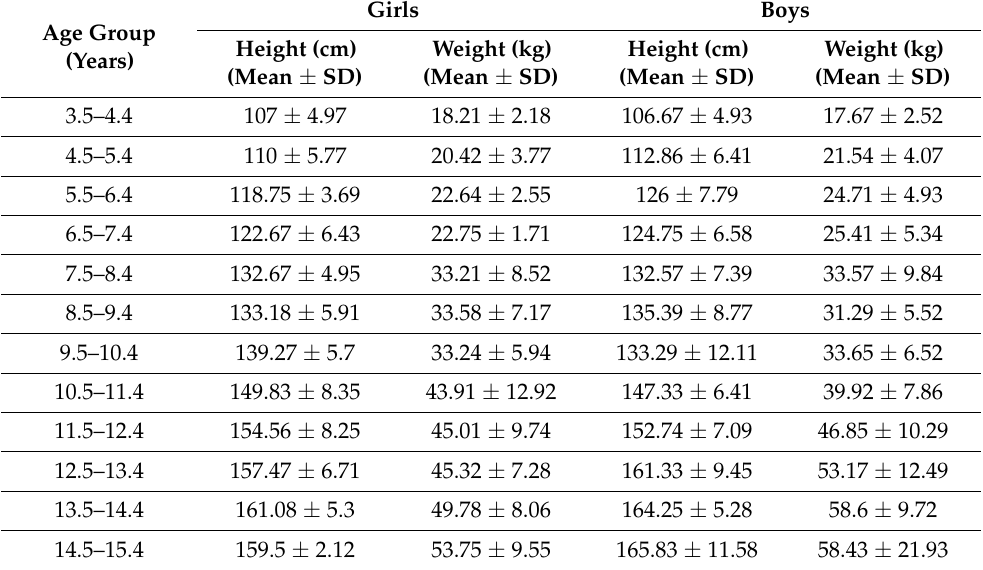
Table 4. Age group distribution of the general growth parameters in study subjects.